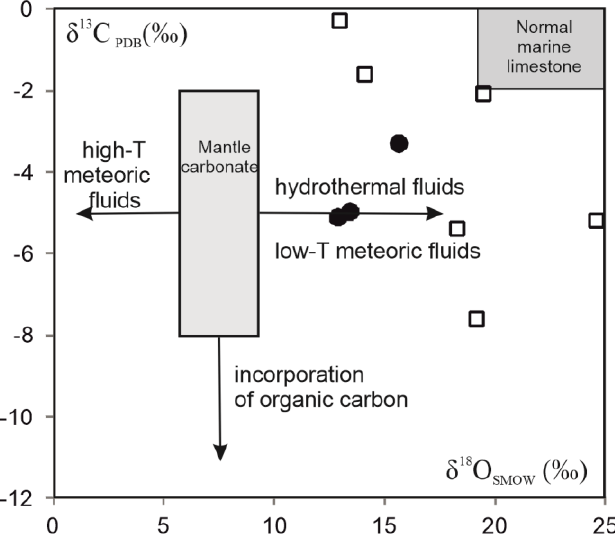
Figure 10. δ 13 C and δ 18 O diagram for agate-associated calcite samples from: • —Yalguba Ridge Figure 10.  13 C and  18 О diagram for agate - associated calcite samples from: ●— Yalguba Ridge occurrences, (cid:3) —other localities around the world [19]. Mantle carbonate box and arrows showing occurrences, □ — other localities around the world [19]. Mantle carbonate box and arrows showing